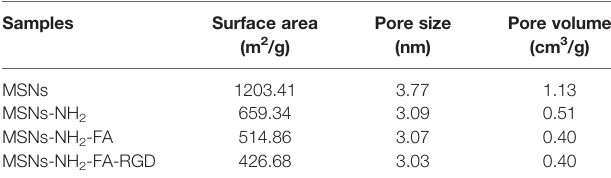
TABLE 1 | The nitrogen adsorption-desorption parameters of different functionalized MSNs